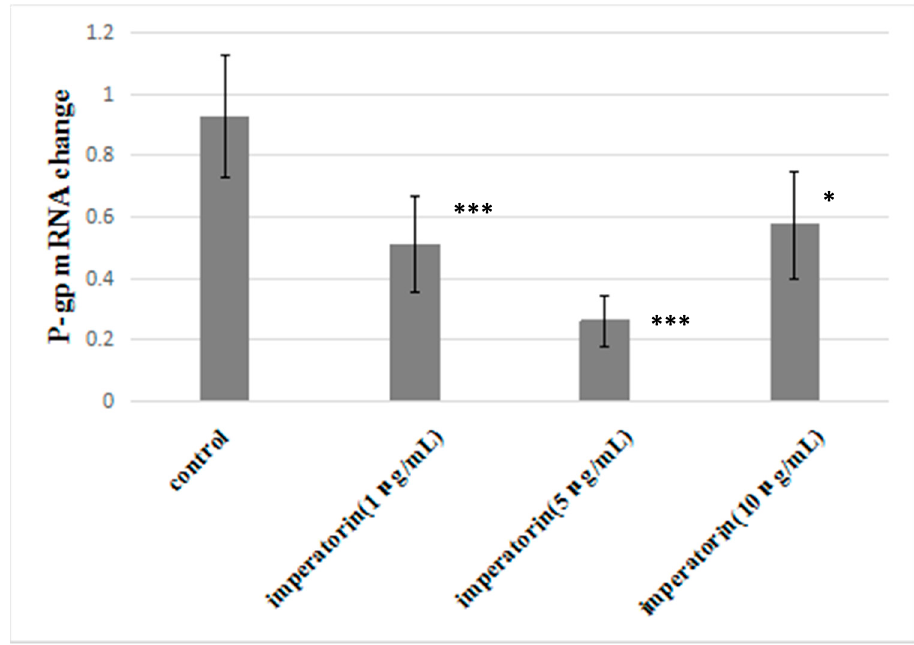
Figure 6. Effect of imperatorin on P-gp mRNA expression in MDCK-MDR1. Statistical significance is denoted * p < 0.05, *** p < 0.001 compared with control group.